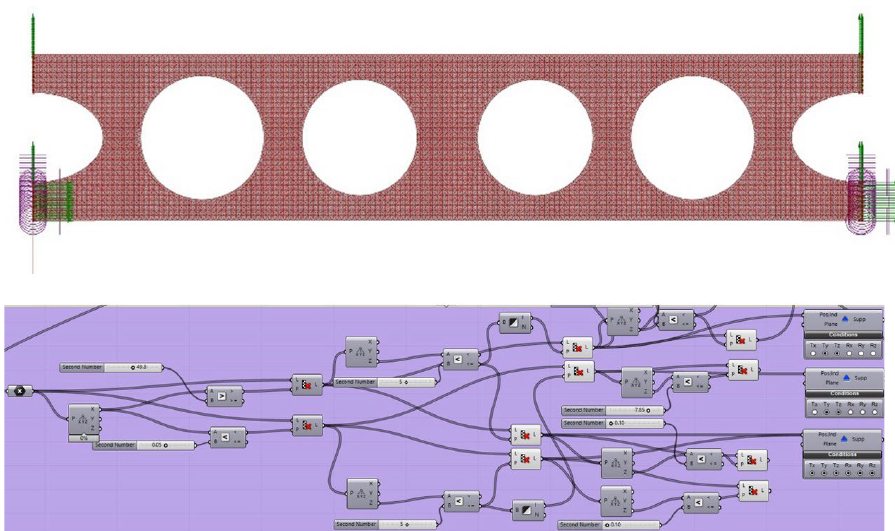
Figure 15. Supports implementation in visual scripting.